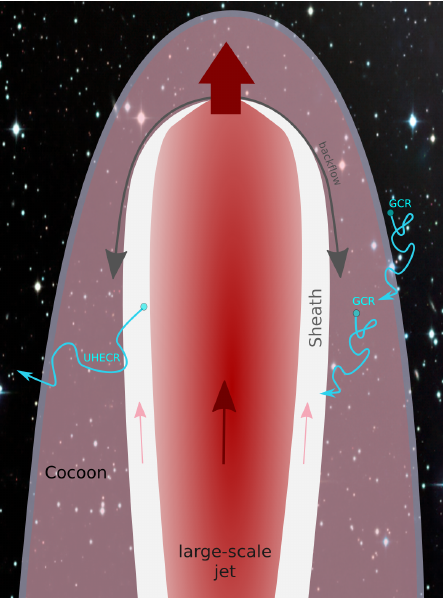
Figure 14. Sketch of an UHECR model for AGN jets, in which some fraction of galactic-type cosmic rays (GCR) permeating the halo are swept up by the jet (“injected”) and shear-accelerated to ultra- high energies in its jet-sheath structure. Stochastic (2nd order Fermi) acceleration by turbulence in the cocoon and first-order Fermi acceleration by shocks in back-flowing regions may further add to particle